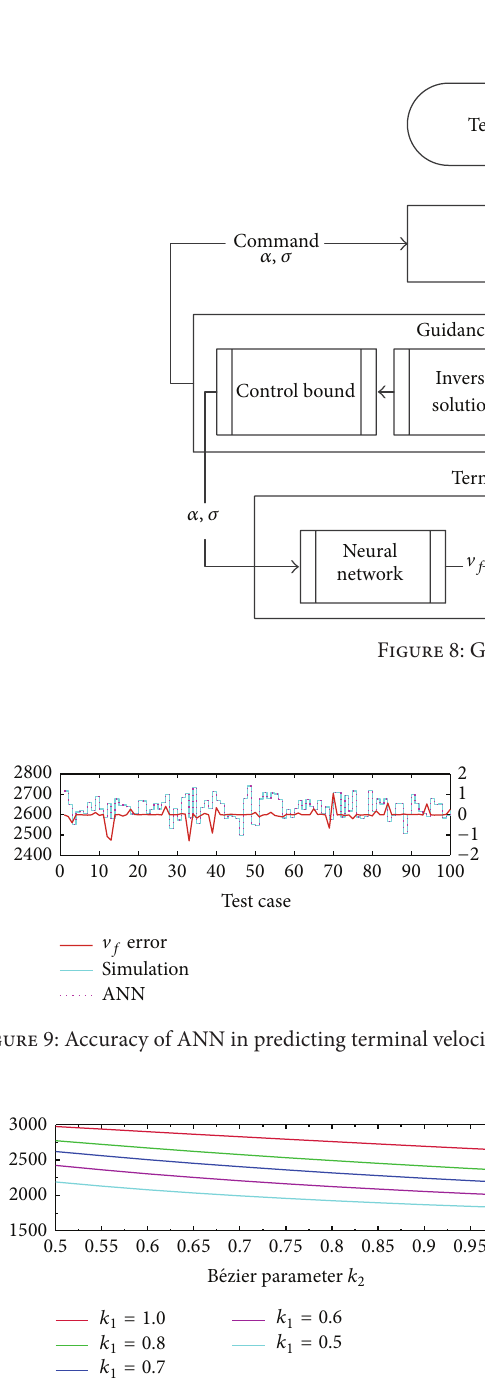
Figure 10: Terminal velocity and 𝑘 2 , 𝑘 1